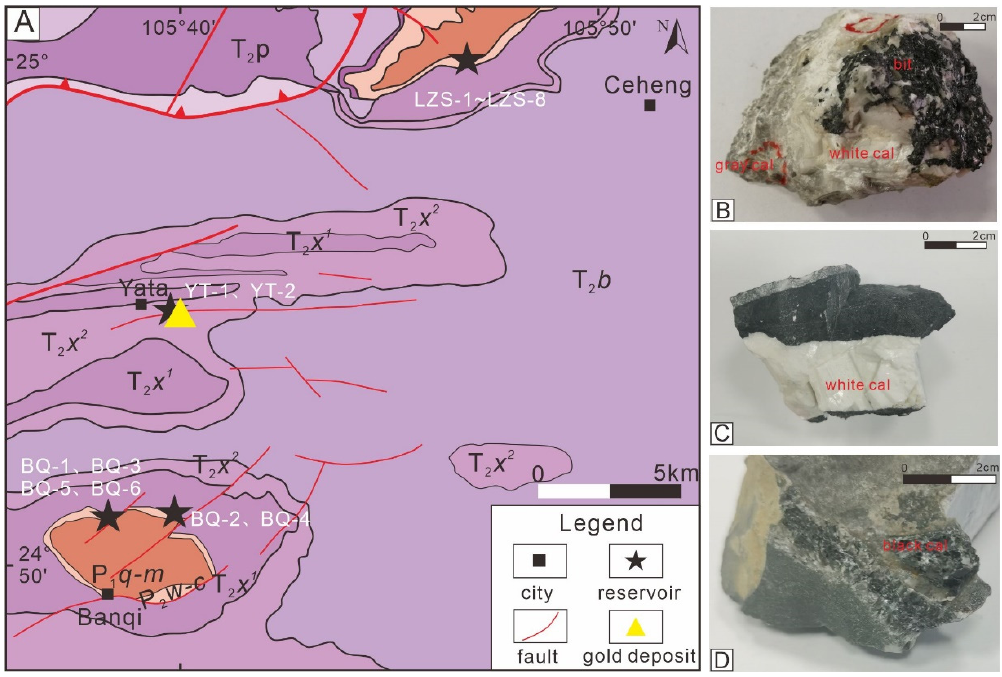
Figure 3. ( A ) Geological map of the Banqi-Yata-Laizishan area showing sample locations. ( B ) gray and white calcite, Laizishan. ( C ) white calcite, Yata. ( D ) black calcite, Banqi. Table 1. Basic information for the calcite samples from the Banqi-Yata-Laizishan area. Samples